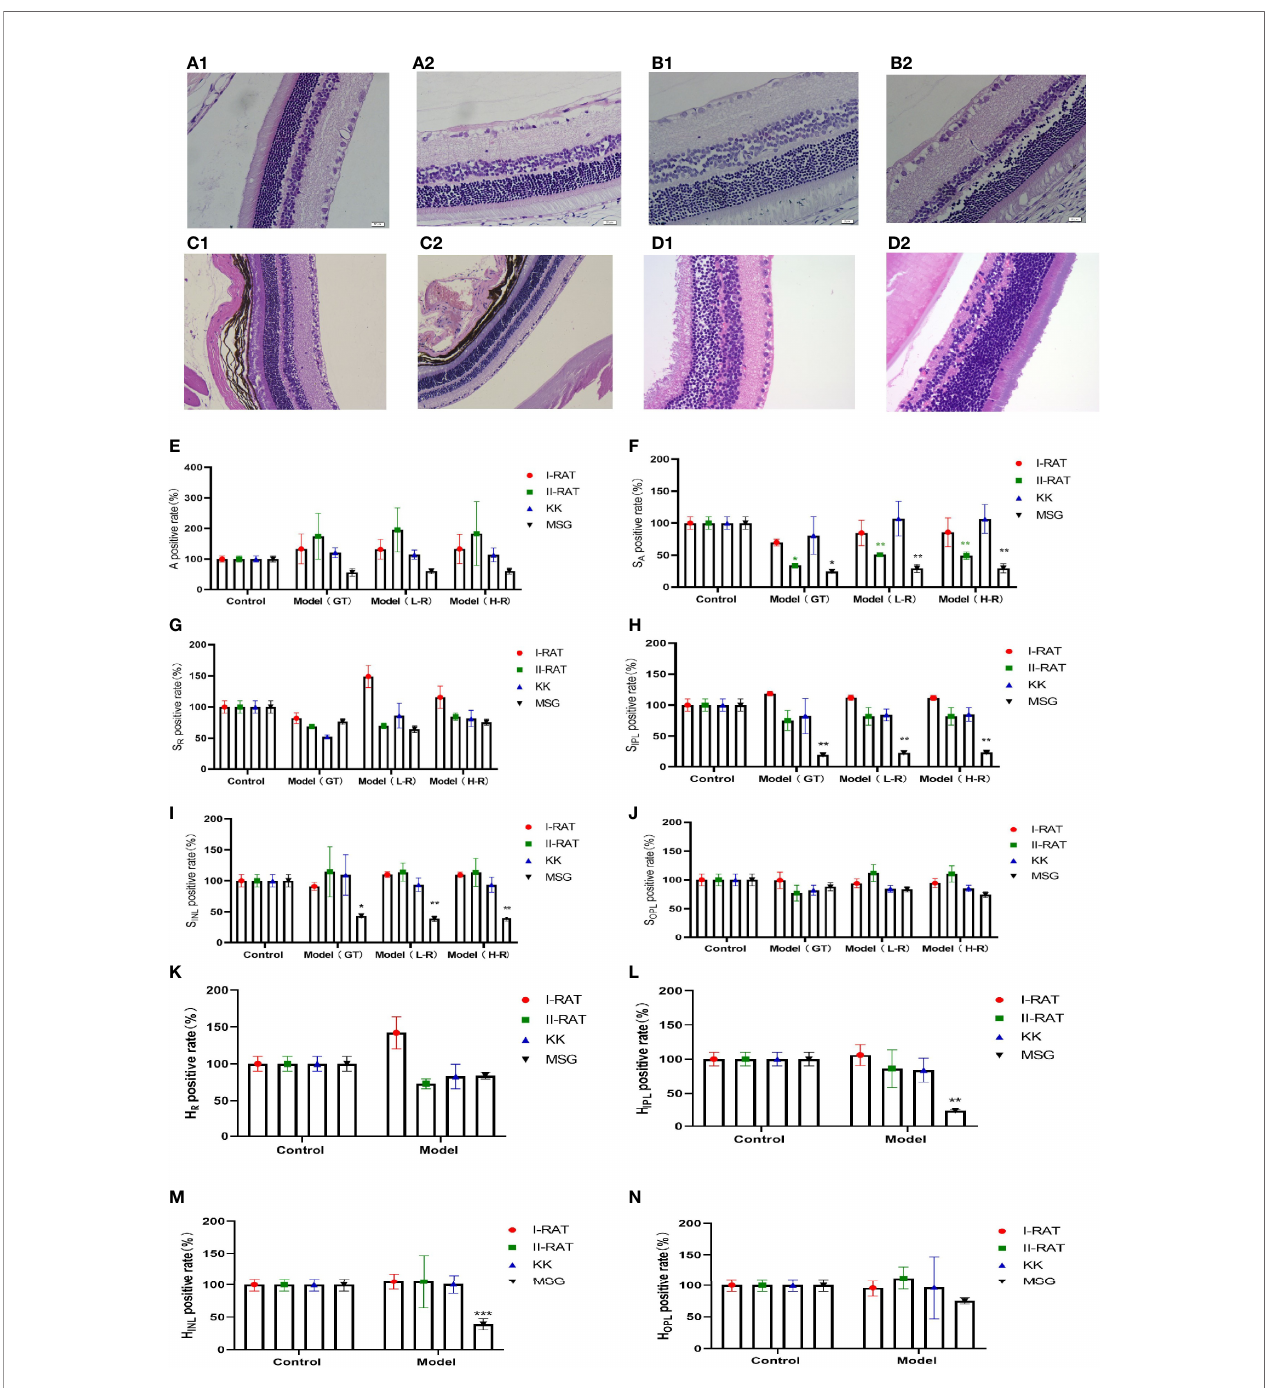
FIGURE 7 | Comparison of the characteristics of retinopathy in diabetic animal models. (A1) Retinal HE section images of type 1 diabetic rats. (A2) Retinal HE section images of SD rats. (B1) Retinal HE section images of type 2 diabetic rats. (B2) Retinal HE section images of SD rats. (C1) HE section image of C57 mouse retina. (C2) HE section image of KK mouse retina. (D1) HE section image of ICR mouse retina. (D2) HE section image of MSG mouse retina. (E) Comparative images of positive retinal ganglion cell numbers in four groups. (F – J) The positive rate of the retinal layer area in four groups was compared. (K – N) Comparative images of positive rate of retinal thickness in four groups. A is the number of ganglion cells, SA is the total area of ganglion cells, SR is the area of retinal nerve fi ber layer (RNFL), SIPL is the area of internal layer (IPL), SINL is the area of kernel layer (INL), SOPL is the area of external network layer (OPL). HR is the thickness of retinal nerve fi ber layer (RNFL), HIPL is the thickness of the internal layer (IPL), HINL is the thickness of kernel layer (INL), and HOPL is the thickness of the external network layer (OPL). Red are type 1 diabetic rats, green are type 2 diabetic rats, blue are KK mice, and black are MSG mice. GT is the result of manual interpretation; L-r is the result of low resolution image AI interpretation; H-r is the result of AI interpretation of the high-resolution image. The Control group for each method is considered 100% vs. control group: * p < 0.05, ** p < 0.01, *** p <